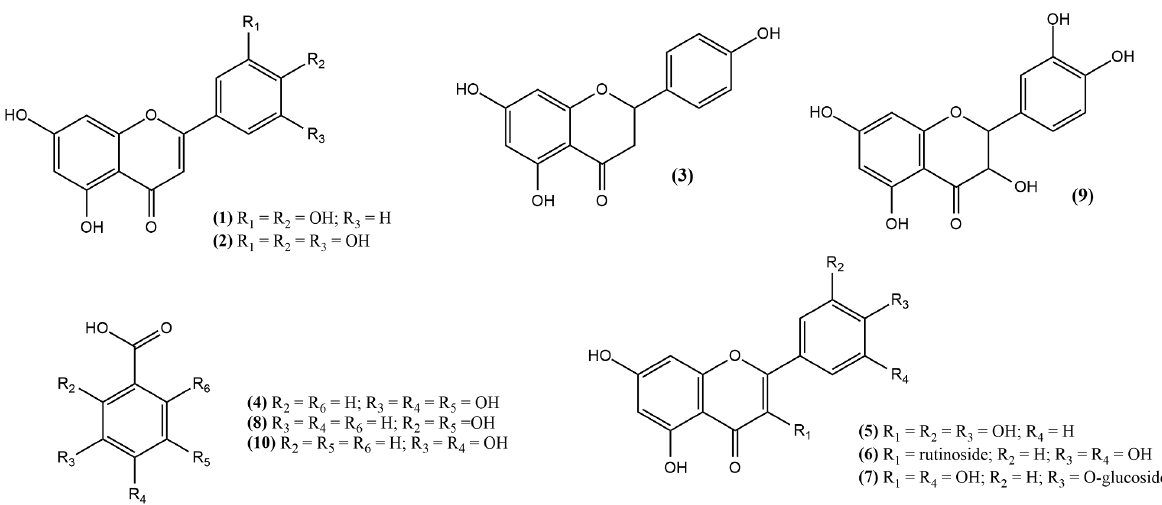
Figure 1. Structures of phenolic compounds identified by GNPS and NAP.